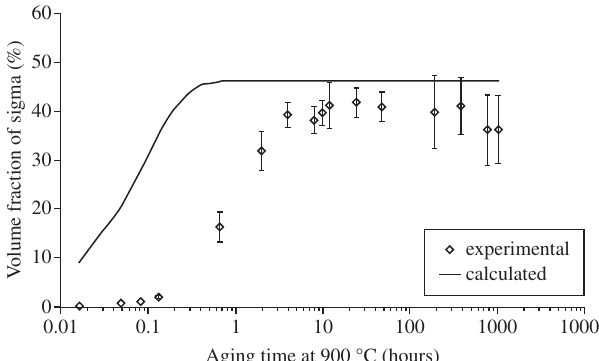
Figure 14. Experimental and calculated sigma phase content (vol. %) as a function of aging time at 750 °C.